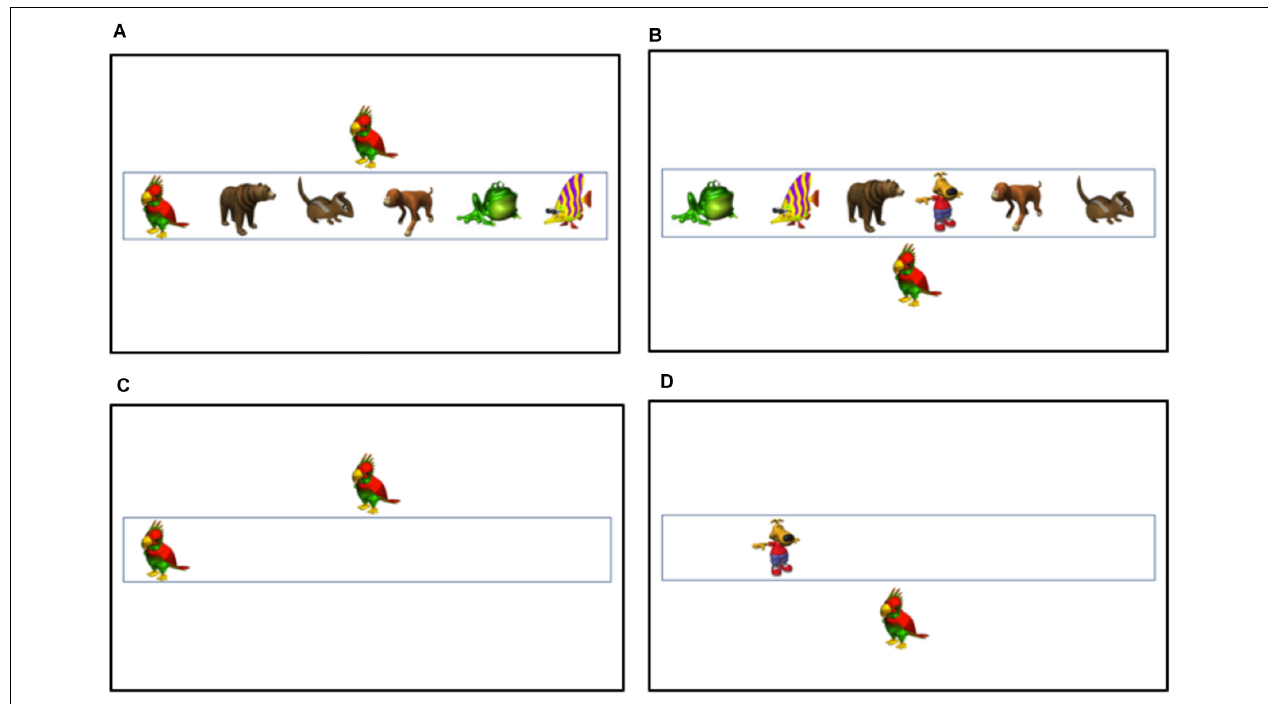
FIGURE 1 | Example trials from the visual distractor conditions: (A) High Load Compatible, (B) High Load Incompatible, (C) Low Load Compatible, and (D) Low Load Incompatible.